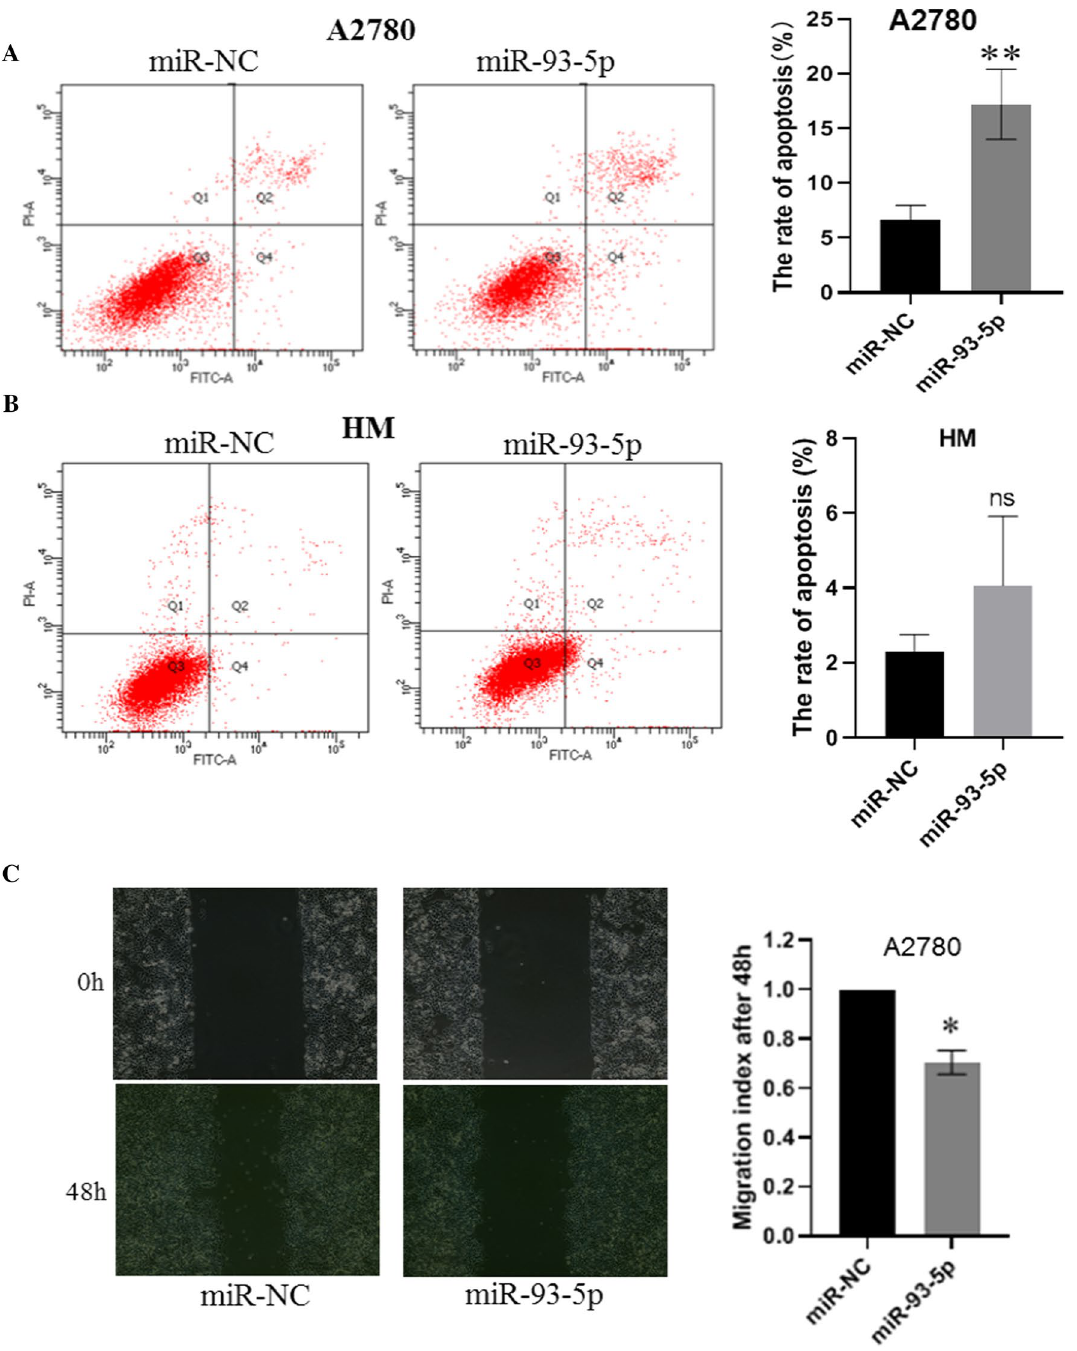
Fig. 3 miRNA-93-5p enhances ovarian cancer cell apoptosis and suppress cell migration. A , B Cell apoptosis was analyzed by using Annex- inV-FITC/PI kit based on flow cytometry approach after cell transfection of miR-93-5p mimic and miR-NC in A2780 cells and HM cells. C Wound healing assay were performed to test the cell migration ability after transfection of miR-93-5p mimic and miR-NC in A2780 cell. *P < 0.05; **P <